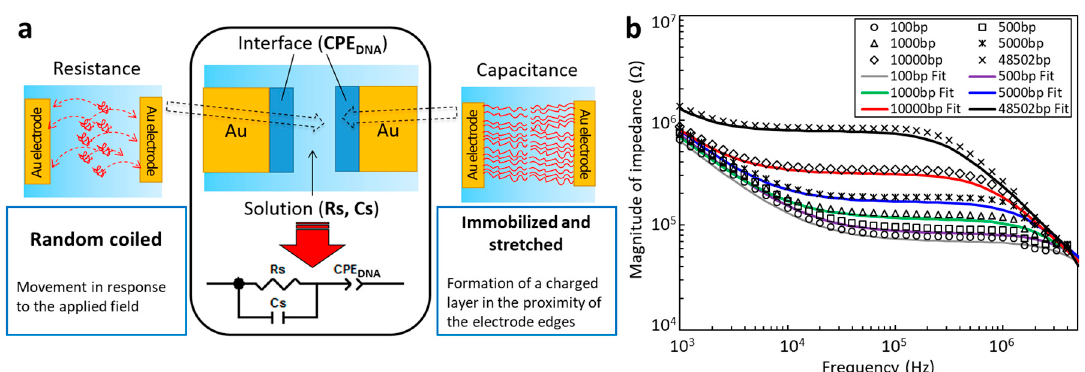
Figure 4. Equivalent circuit model used to quantitatively evaluate the impedance responses. ( a ) An electric circuit model for the impedance of DNA solutions in nanogap electrodes. ( b ) Fitting of the impedance responses of solutions of DNA ranging from 100 bp to 48.5 kbp in length.